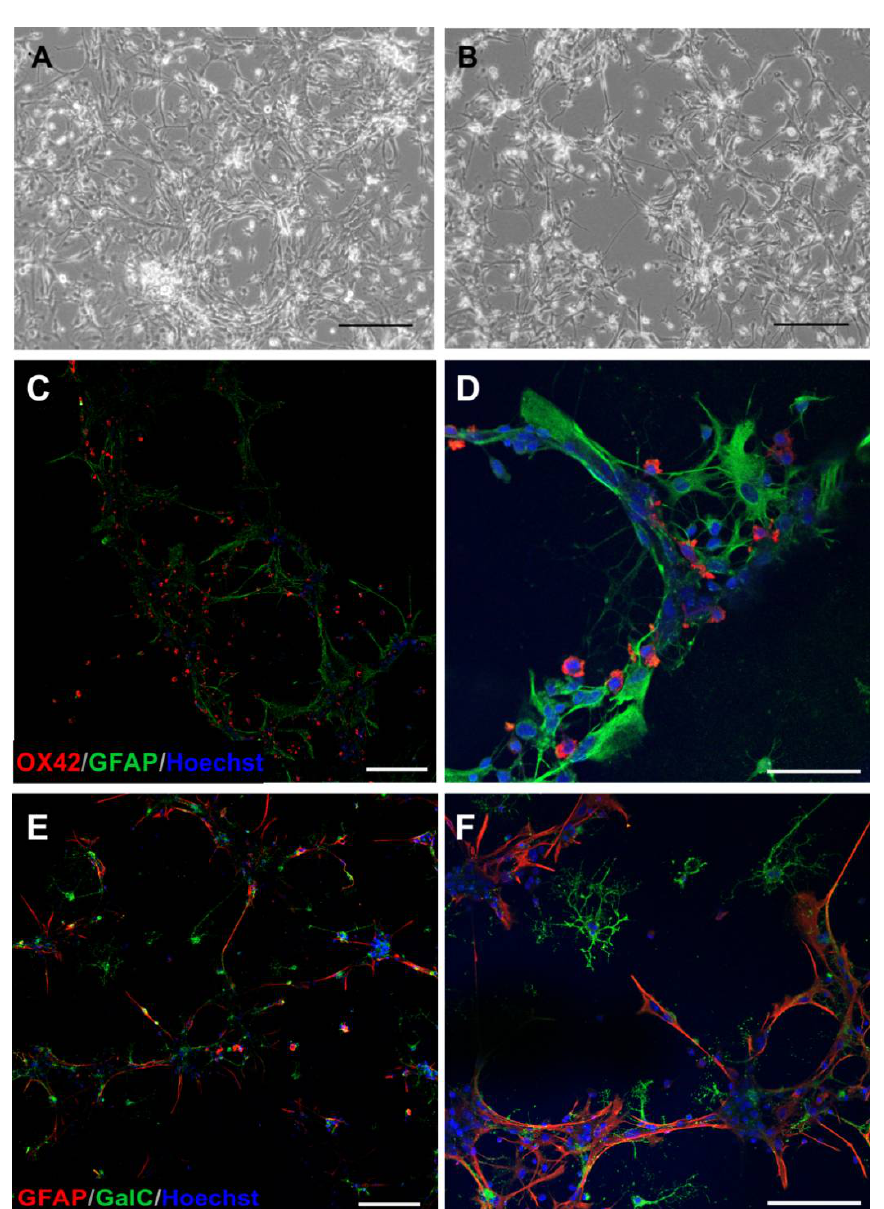
Figure 9. Coculture of rat neonatal astrocytes with either microglia or oligodendrocytes. ( A ) Live imaging of control astrocyte-oligodendrocyte coculture; ( B ) Live imaging of coculture subjected to OGD procedure; ( C , D ) Immunostaining of microglia-astrocyte coculture stained with specific antibodies to distinguish the type of cultures cells: OX42 for microglia (red) and GFAP for astrocytes (green); ( E , F ) Astrocytes (GFAP + , red) cocultured with differentiating GalC-positive (green) oligodendrocytes. Cell nuclei are stained with Hoechst dye (blue). The scale bar is an equivalent of 50 μm.